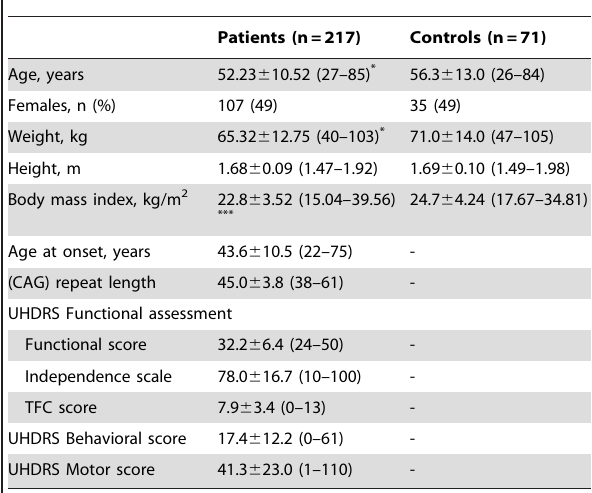
Table 1. Baseline characteristics of the patients with Huntington’s disease and their age- and sex-matched